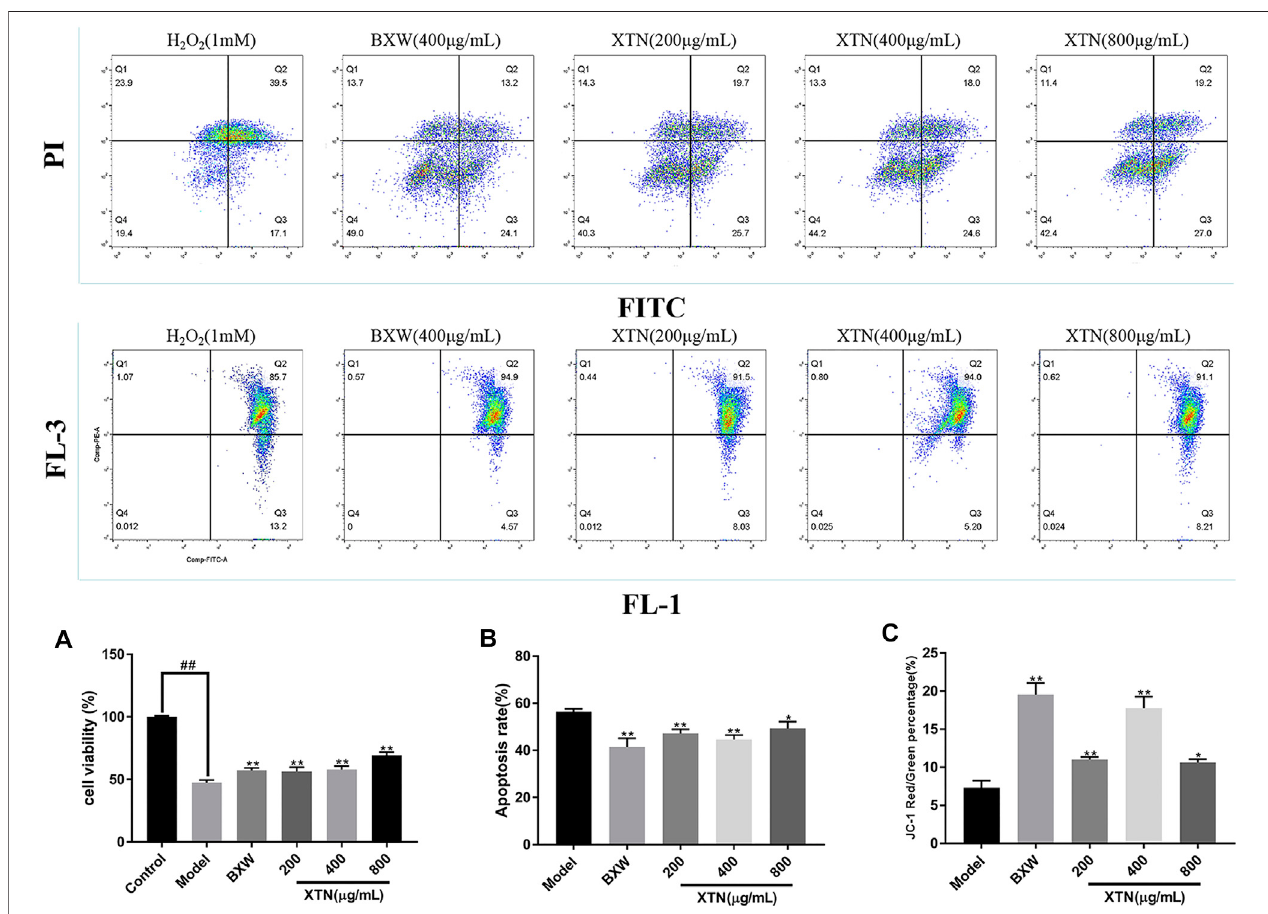
FIGURE4| XTNprotectsH9c2sfromH 2 O 2 -inducedcardiomyocyteinjury. (A) EffectsofXTNoncellviability (B) EffectsofXTNonapoptoticrate. (C) EffectsofXTN on JC-1 red/green percentage (%). Data are expressed as the mean ± standard deviation ( n (cid:2) 3). * p < 0.05, ** p < 0.01 vs. model group.